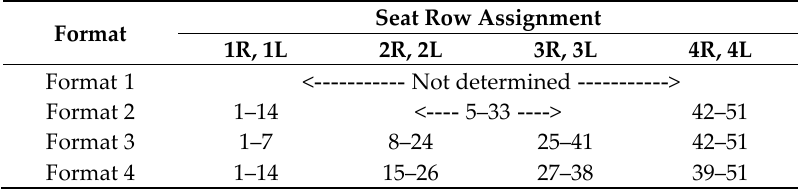
Figure 2. The evacuation times of 4 formats. Table 4. Seat row assignment in each format.